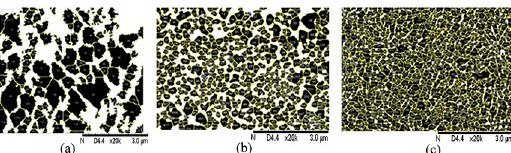
Figure 3. Analyze particle in clad zone for (a) chromium, (b) molybdenum and (c) mixture. In Figure 4(a), the as-received grey cast iron sample consists of ferrite (α-Fe), cementite (Fe C) and graphite 3 phases. The α-Fe phase intensity reduced to 34.2 %, 64.3 % and 60.5 % in respective to the Cr, Mo and Cr-Mo cladding samples. The graphite phases were absent in all the cladding layers patterns shown in Figures 4(b)-(d). Meanwhile, the carbide phases were only detected in Mo and Cr-Mo added cladding layer, which are M C, M C and M C . In Figure 2 23 6 3 2 4(c), apart from the carbide phases, the cladding layer also comprised retained austenite.